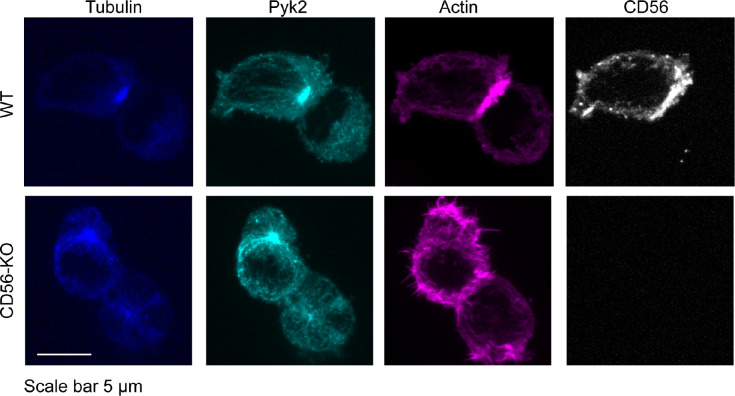
Detection of total Pyk2 in WT and CD56-KO cell lines.WT (top) or CD56-KO (bottom) NK92 cells were conjugated to K562 targets then fixed, permeabliized and immunostained for tubulin, Pyk2, actin (phalloidin) and CD56. Images were acquired on a spinning disk confocal microscope. Shown is one representative of 60 cells from two independent technical replicates.